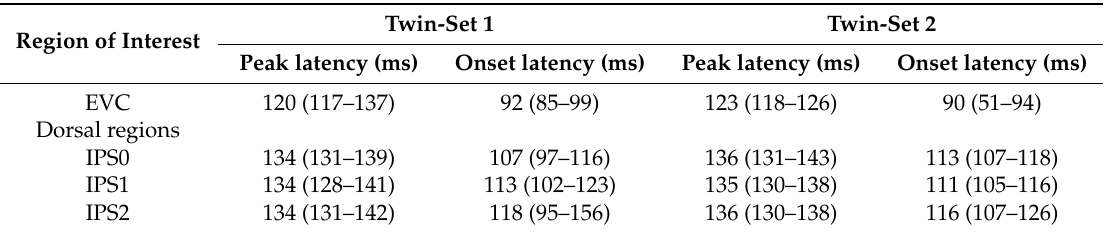
Figure 8. Comparing dorsal and ventral stream neural representations through similarity-based ROI fMRI-MEG fusion. The voxel patterns are extracted from each ROI to construct the fMRI ROI RDM. Then the ROI-specific fMRI RDM was compared with time-resolved MEG RDMs resulting in correlation time series for each region of interest; ( a,b ) The fMRI-MEG fusion time series are depicted in EVC and ventral ROIs, LO, VO, PHC, and TO for Twins-set and ImageNet-set, respectively; ( c,d ) The fMRI-MEG fusion time series are depicted in EVC and dorsal ROIs, IPS0-3 for Twins-set and ImageNet-set, respectively. The color-coded lines below the curves indicate significant time points (n = 15, cluster-definition threshold P < 0.01, cluster threshold P < 0.01) and the dashed vertical line in each plot indicates the peak latency in EVC time series. Peak latency times and their corresponding 95% confidence intervals for correlation time series in bcde are illustrated with barplots and error bars, respectively. Black lines above the bar indicate significant differences between conditions. 95% confidence intervals were found with bootstrap tests and barplots were evaluated with two-sided hypothesis tests; false discovery rate corrected at P < 0.05. Table 1. Peak and onset latency for fMRI-MEG fusion time series in EVC, ventral, and dorsal regions for Twin-Set 1 and Twin-Set 2 (Experiment